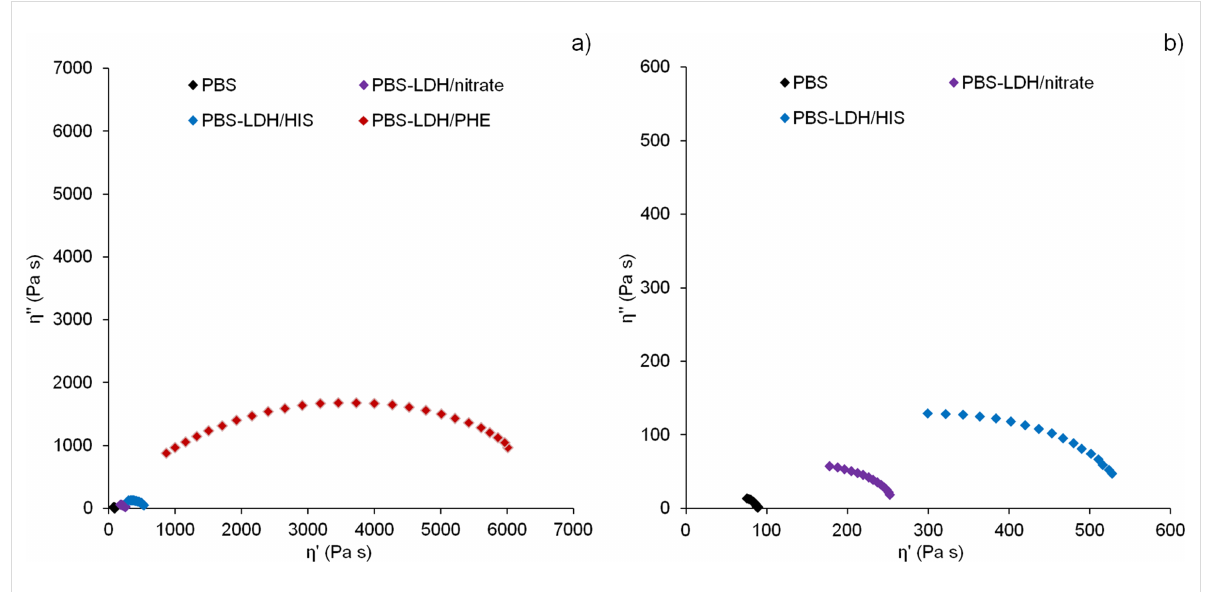
Figure 7: Cole–Cole plots of PBS and PBS nanocomposites with Mg 2 Al LDH (a), zoom region (b).